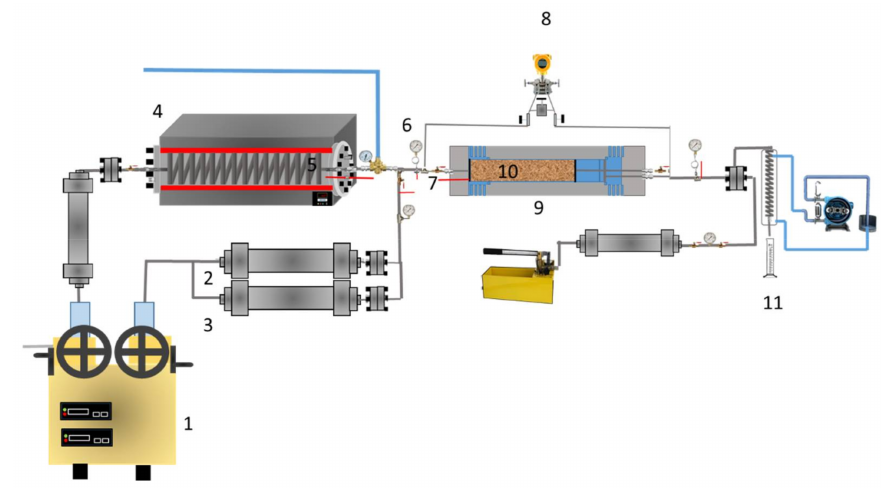
Figure 4. Schematic representation of the experimental setup. Legend: (1) the displacement positive pumps the core holder, (2) the oil-containing displacement cylinder, (3) the water-containing displacement cylinder, (4) the tubular furnace (5) the coil line (6) the manometers, (7) the thermocouple, (8) the pressure transducer, (9) the slim tube, (10) the sand packed bed and (11) sample